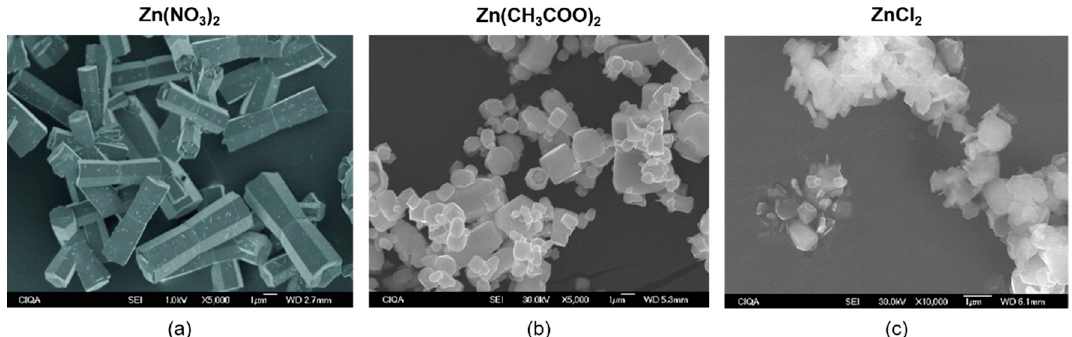
Figure 5. Field-emission (FE)-SEM images of ZnO nanostructures produced via MW-assisted synthesis at 140 ◦ C and 600 W. The image shows the effect that using different precursor salts ( a ) Zn(NO 3 ), ( b ) Zn(CH 3 COO) 2 , and ( c ) ZnCl 2 , has on the morphological development of ZnO during MW synthesis. Scale bar is 1 µ m. Adapted with permission from Reference [103].